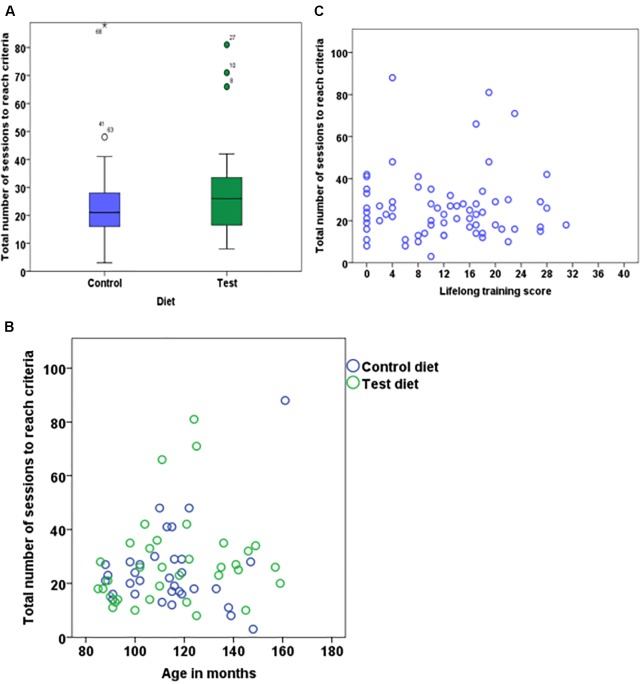
Boxplot showing number of sessions to reach criterion for dogs that received either test diet or control diet (A) (n = 68, p = 0.47). Scatter plot showing the relationship between age in months and number of sessions to reach criterion (B) (n = 68, p = 0.05). Scatter plot showing the relationship between lifelong training score and number of sessions to reach criterion (C) (n = 68, p = 0.54).